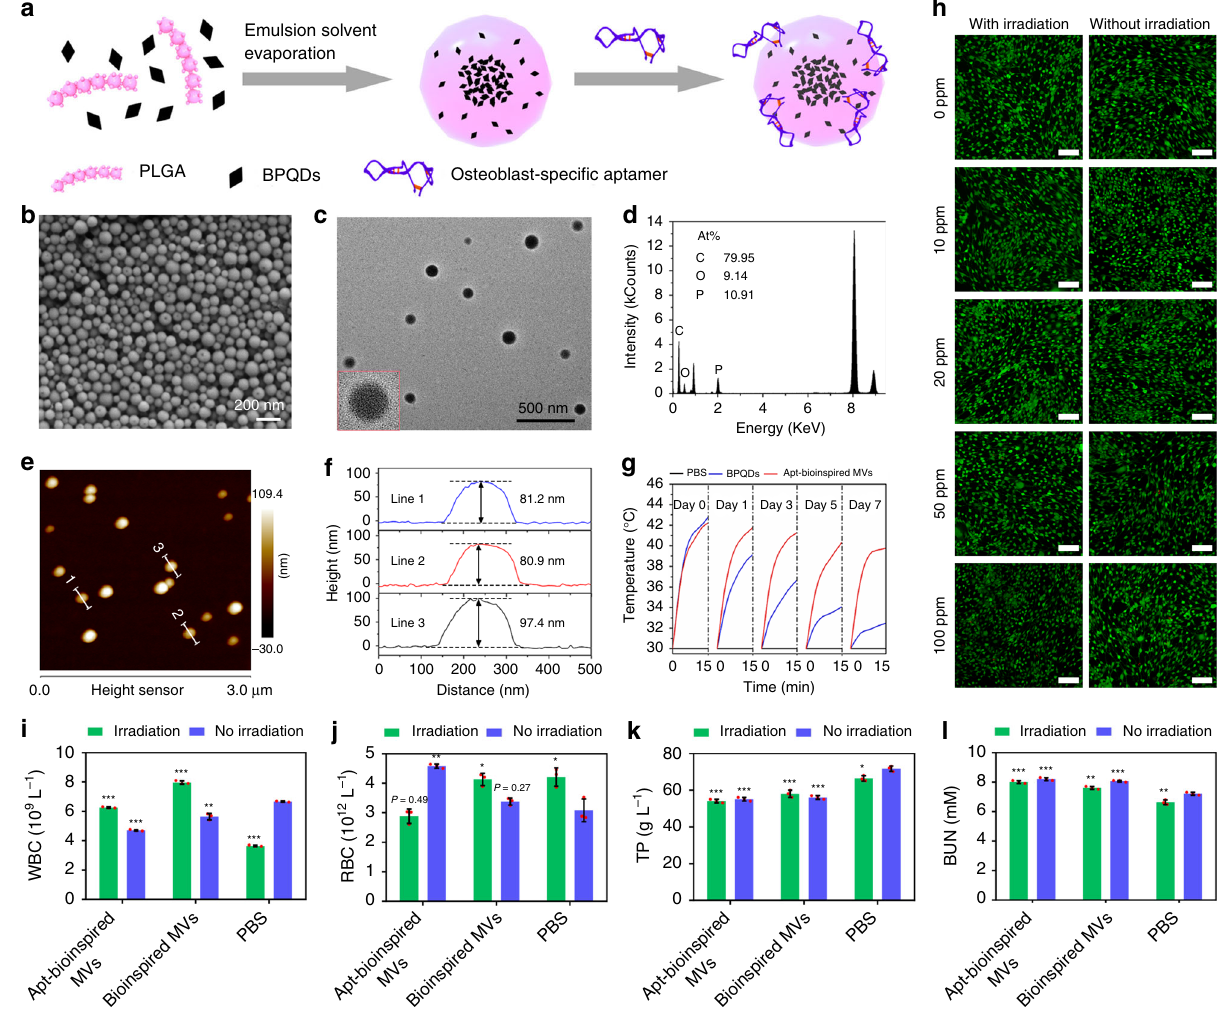
Fig. 2 Characterization of the Apt-bioinspired MVs. a Schematic representation of the preparation of Apt-bioinspired MVs. b SEM image, c TEM image, d EDX analysis, and e AFM image of Apt-bioinspired MVs. f Height pro fi les along the white lines in graph e . g Photothermal curves of bare BPQDs and Apt- bioinspired MVs under NIR irradiation (1.0 W cm − 2 ) after storing in PBS for 0, 1, 3, 5, and 7 days. PBS was used as the control. h Fluorescence images of dead/live cell staining after incubation with Apt-bioinspired MVs. Scale bars represent 150 μ m. Hematological analyses of mice with indexes of ( i ) white blood cell count (WBC) and ( j ) red blood cell count (RBC). Blood biochemical analyses of mice with indexes of ( k ) total protein (TP), and ( l ) blood urea nitrogen (BUN). Data are means ± s.d. ( n = 3), * P < 0.05, ** P < 0.01, *** P < 0.001 (unpaired two-tailed Student ’ s t -test). Source data of b – g , i – l